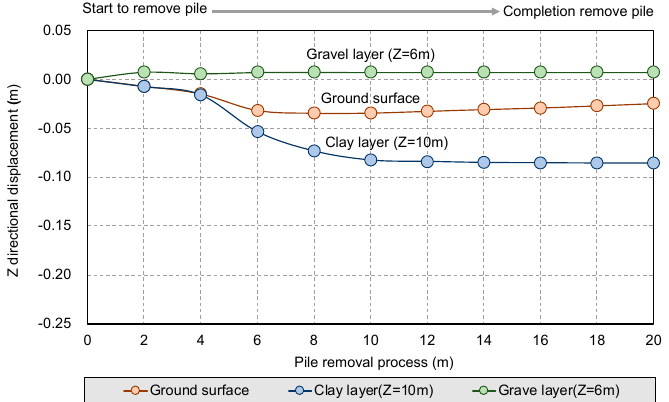
Figure 4. Subsidence of the surrounding ground during the process of forming one extraction hole of a removed pile.